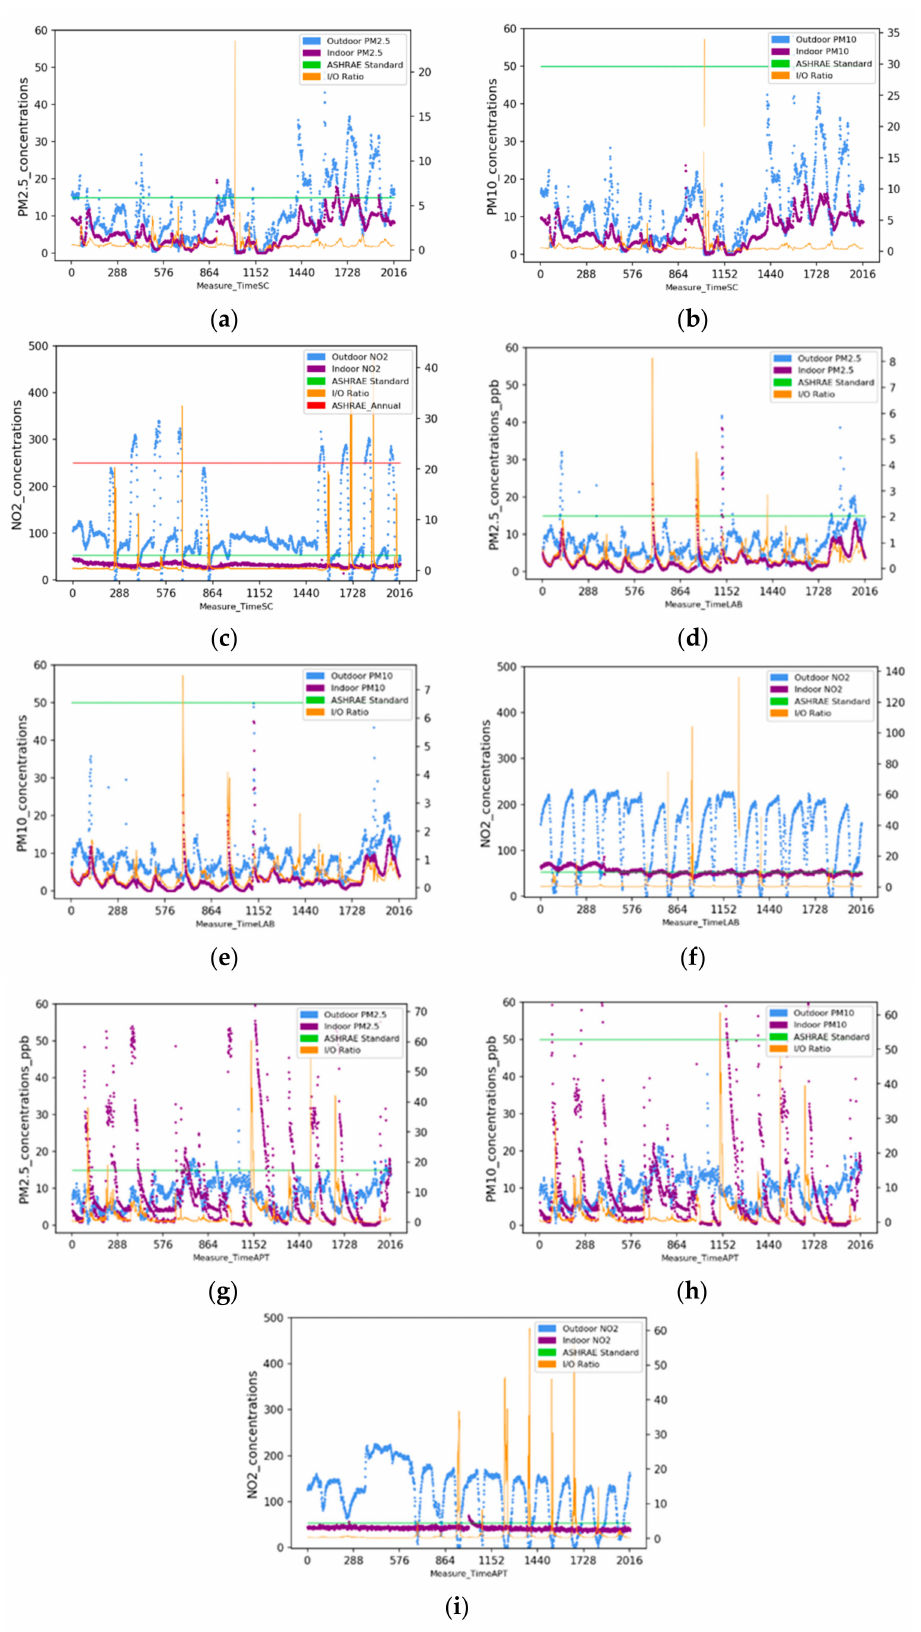
Figure 2. Two weeks evaluation of indoor and outdoor pollutants monitored at 10-min intervals (144 observational points a day equating to 2016): ( a ) Site 1-PM 2.5 , ( b ) Site 1-PM 10 , ( c ) Site 1-NO 2 , ( d ) Site 2-PM 2.5 , ( e ) Site 2-PM 10 , ( f ) Site 2-NO 2 , ( g ) Site 3-PM 2.5 , ( h ) Site 3-PM 10 , ( i ) Site 3-NO 2